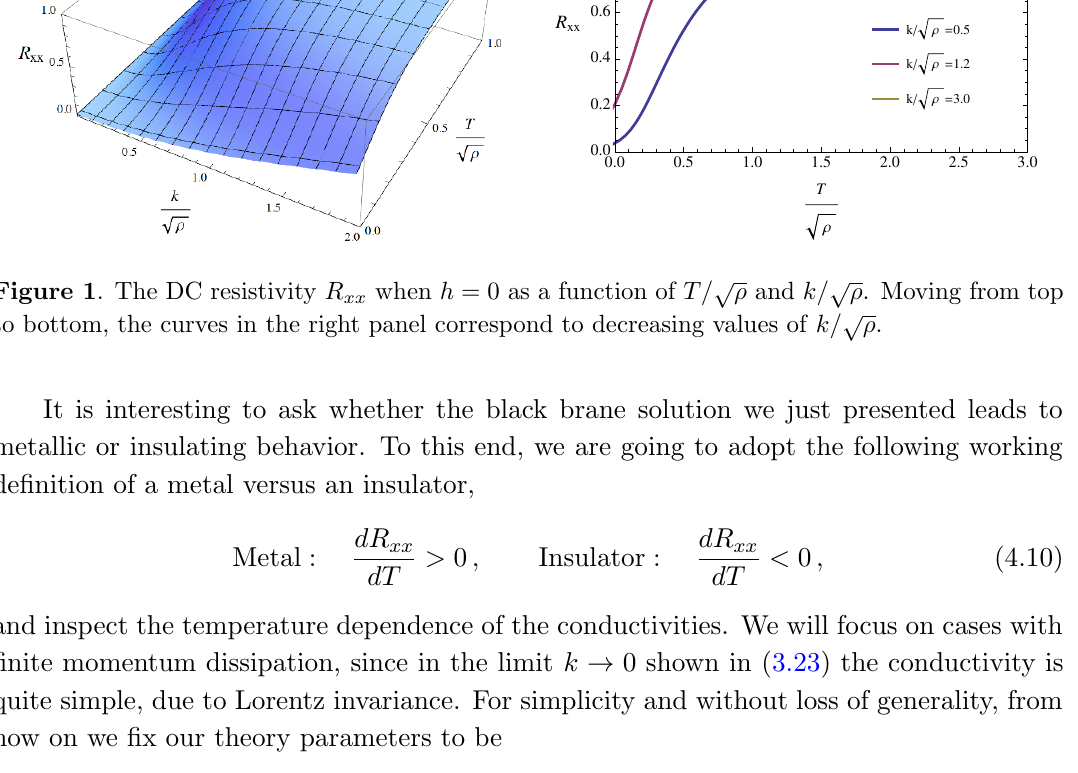
Figure 1 . The DC resistivity R xx when h = 0 as a function of T= to bottom, the curves in the right panel correspond to decreasing values of k=